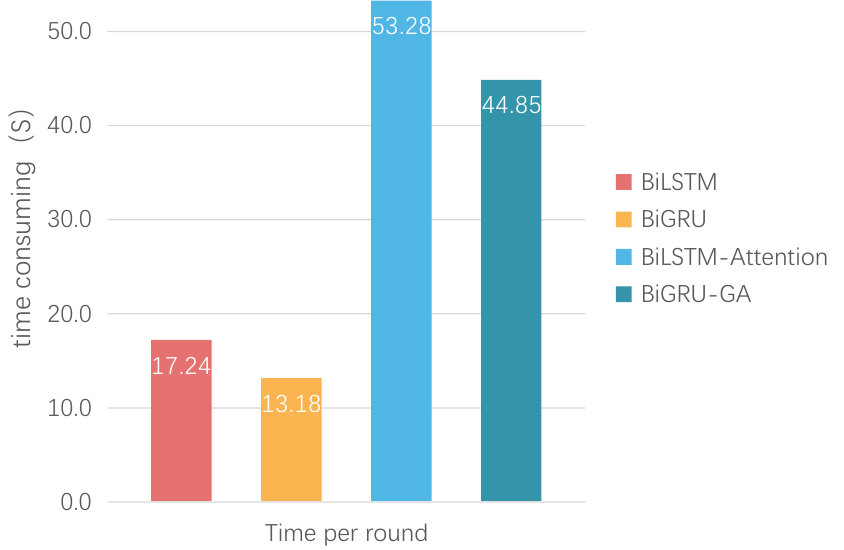
Figure 18. Each round of the relation extraction model takes time to compare the experimental results.